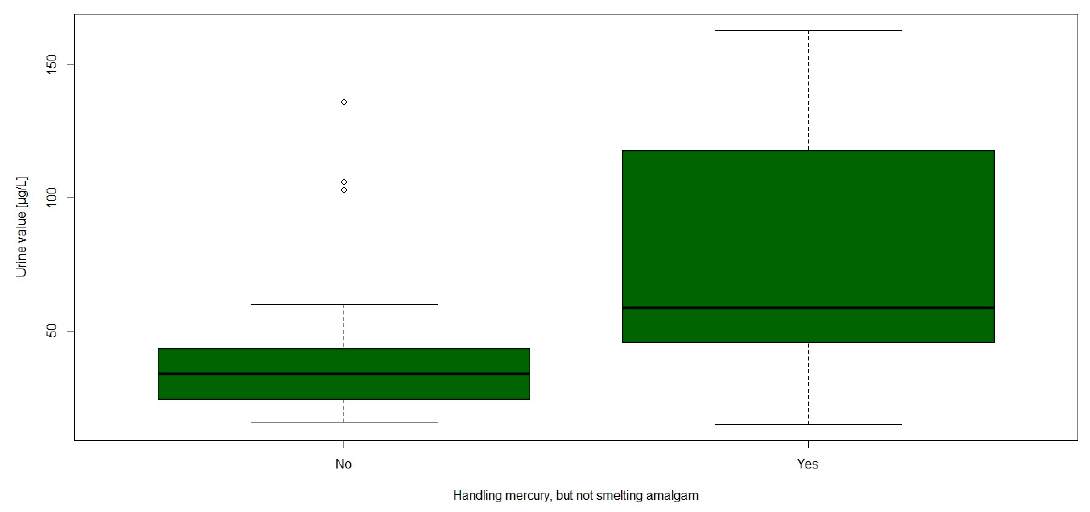
Figure 5. Boxplot of mercury in urine stratified by the job category “Handling mercury, but not smelting amalgam”.